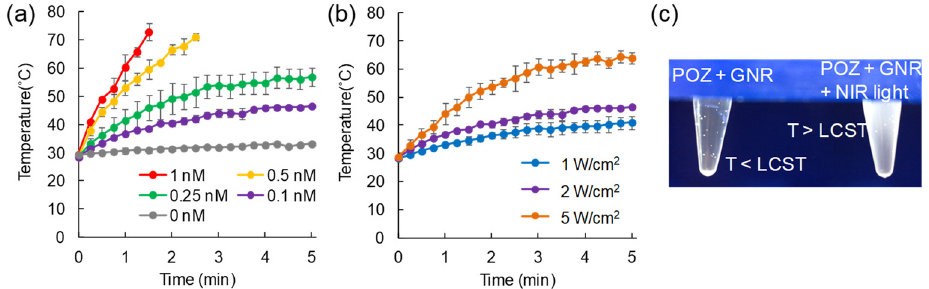
Figure 3. Photothermal effect of gold nanorods (GNRs) irradiated with near-infrared (NIR) light. ( a ) Temperature elevation over a period of 5 min of NIR light irradiation (2 W/cm 2 ) at different GNR concentrations (0–1 nM). ( b ) The effect of NIR light dose (1–5 W/cm 2 ) on temperature elevation (GNR concentration: 0.1 nM). ( c ) Aggregation of polyoxazoline (POZ) via heat yielded from GNR by NIR light irradiation.